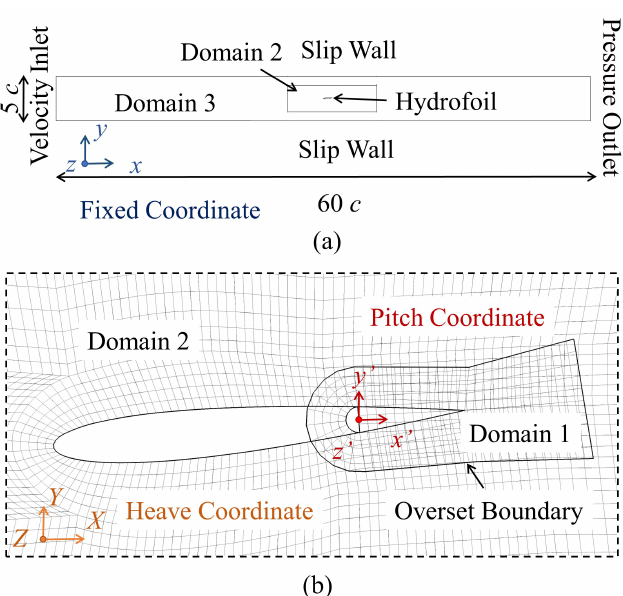
Fig. 7: (a) Background computational domain and, (b) inner compu- tational domain and